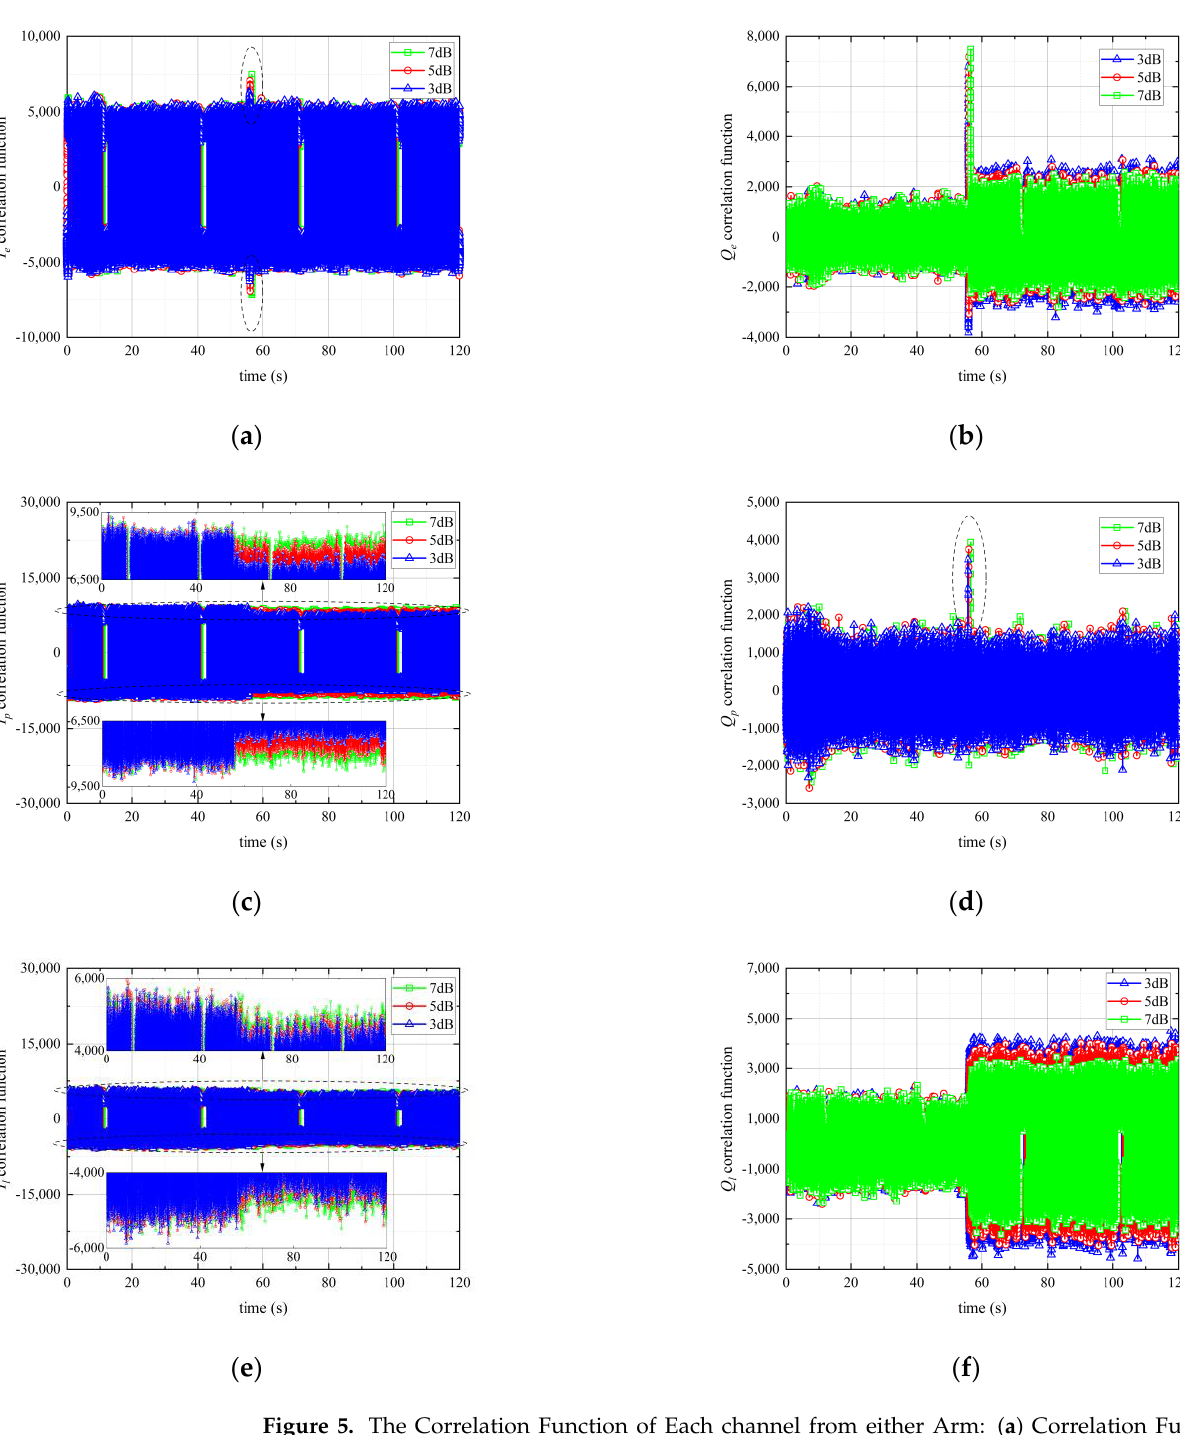
Figure 5. The Correlation Function of Each channel from either Arm: ( a ) Correlation Function of E Channel from In-phase arm; ( b ) Correlation Function of E Channel from Quadrature arm; ( c ) Correlation Function of P Channel from In-phase arm; ( d ) Correlation Function of P Channel from Quadrature arm; ( e ) Correlation Function of L Channel from In-phase arm; ( f ) Correlation Function of L Channel from Quadrature